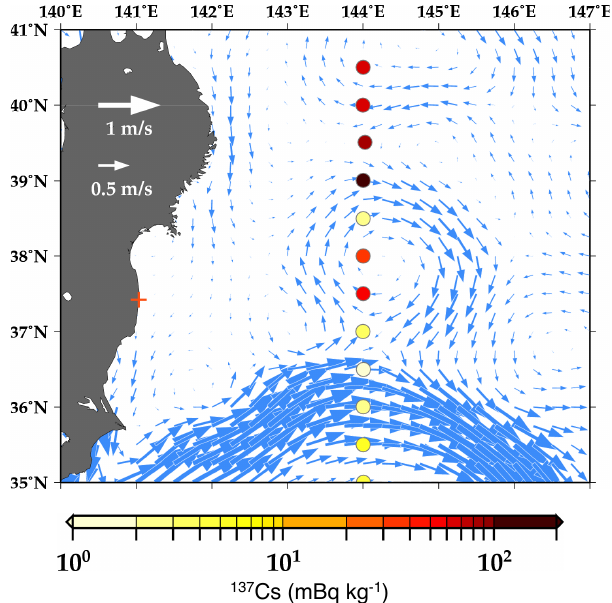
Fig. 2. Sampling locations for surface seawater around the anticy- clonic eddy observed in July 2011. Color of the closed circles in- dicates concentration of 137 Cs in the surface seawater. Blue arrows indicate the estimated temporal mean velocity vectors for the period between 30 June and 29 July 2011.